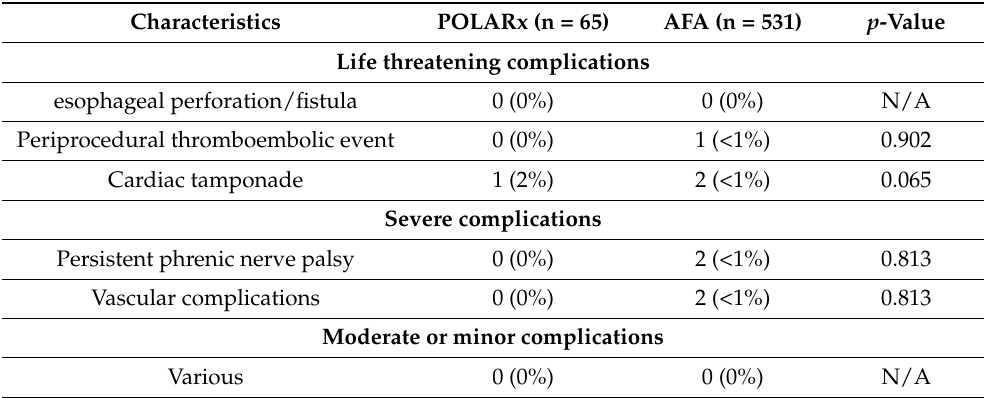
Table 6. Procedure related